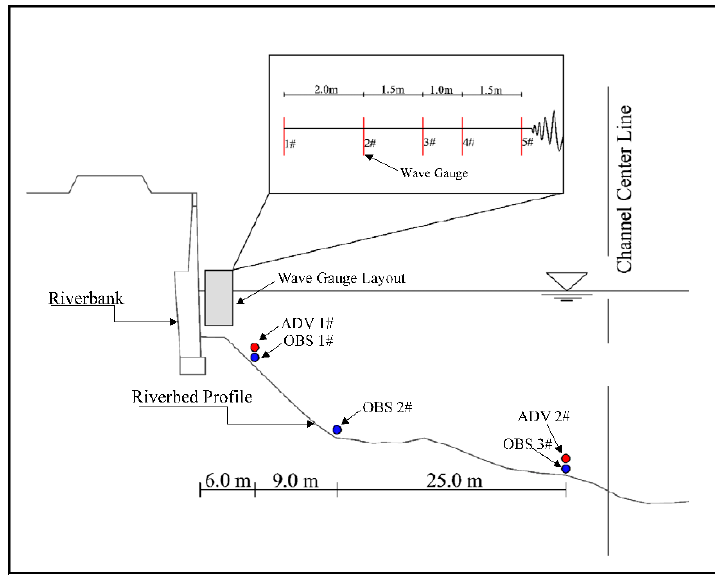
Figure 2. Layout of the equipment.